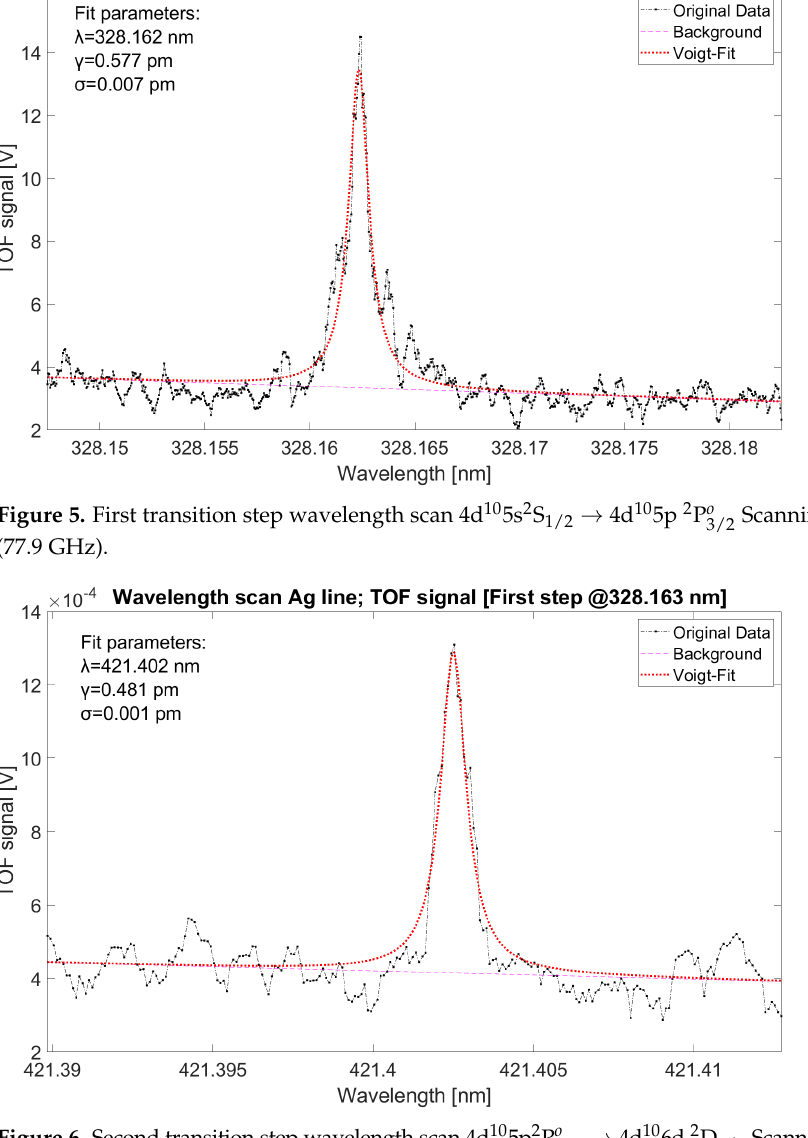
Figure 6. Second transition step wavelength scan 4d 10 5p 2 P o (37.2